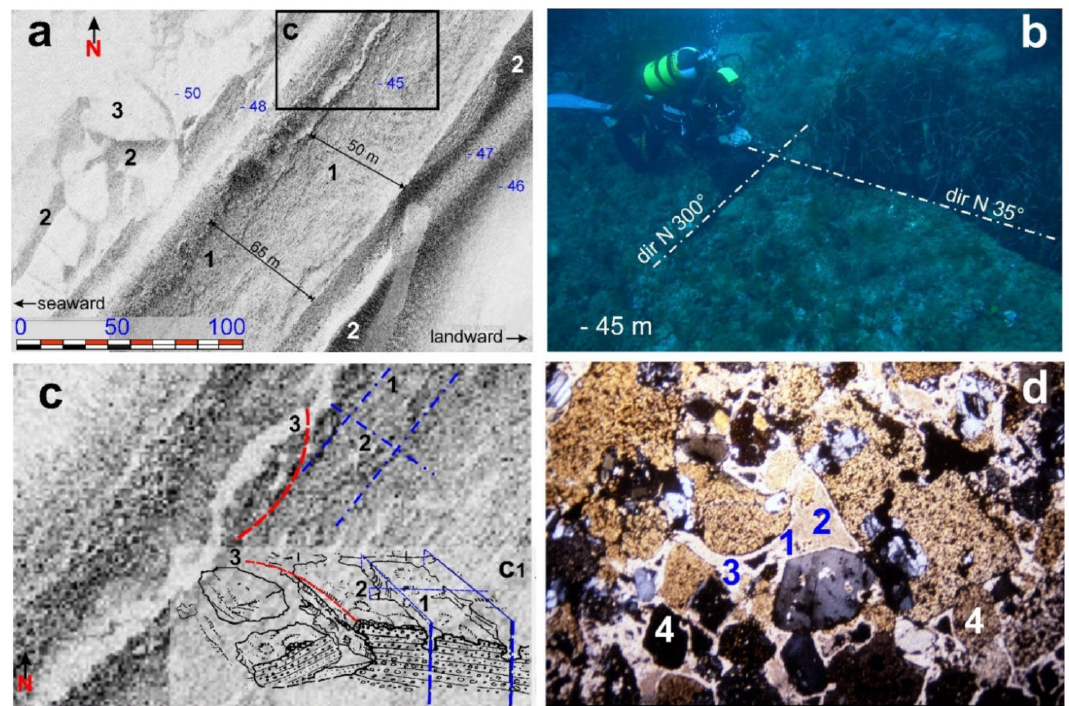
Figure 13. ( a ) The 100 kHz side scan sonar image of the beachrock a depth of 45 m: (1) Outcrop of sandstones and micro-conglomerates with carbonate cement; (2) sandpatches sedimentary structures (mäerl); (3) medium and fine grained bioclastic sands. ( b ) Seabed picture a depth of 45 m, underwater survey of beachrock fracture system. ( c ) Detail of the beachrock outcrops affected by a sub-orthogonal fracture system and by block toppling due to basal erosion: 1—35 ◦ N fracture system; 2—300 ◦ N fracture system; 3—detachment niche; ( c 1 ) block diagram by diving survey. ( d ) Petrographic thin section of the beachrock—45 m: (1) acicular magnesian calcite coating: (2) micritic globular filling; (3) dissolution cavity with secondary clastic-micritic filling; (4) accretion of idiomorphic calcite in dissolution cavity. N.I. ×